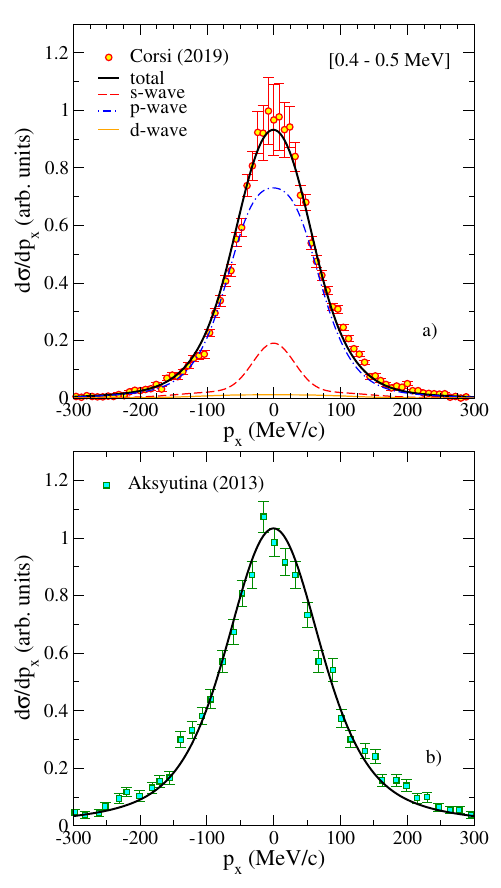
Figure 3. a) Transverse momentum distribution of the knocked-out neutron in the 14 Be( p , pn ) 13 Be reaction at 265 MeV / nucleon [14]. The 13 Be energy range (0.4-0.5 MeV) cor- responds to the shaded area in Fig. 2, right panel. Calculations have been convoluted with the experimental resolution. b) The same but for the reaction at 304 MeV / nucleon [13, 25].